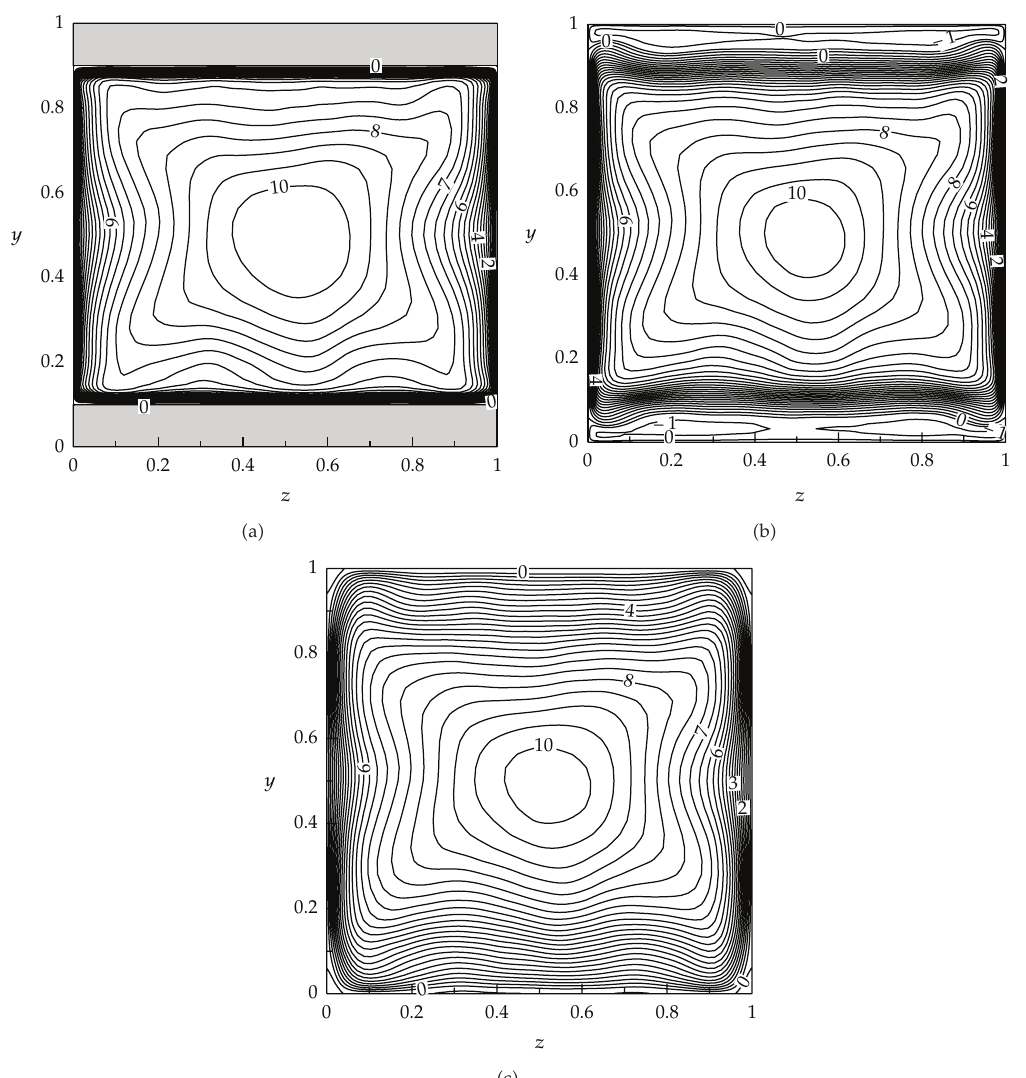
Figure 13: Time-averaged contours of streamwise velocity, u ∗ (cid:8) u × u avg /u τ (cid:2) locations same as in Figure 10 (cid:3) .